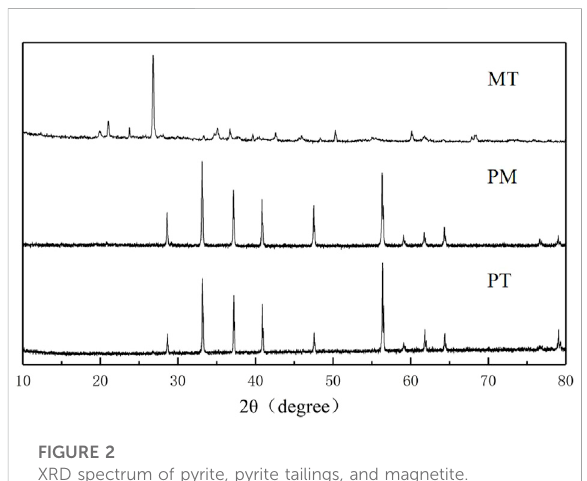
FIGURE 2 XRD spectrum of pyrite, pyrite tailings, and